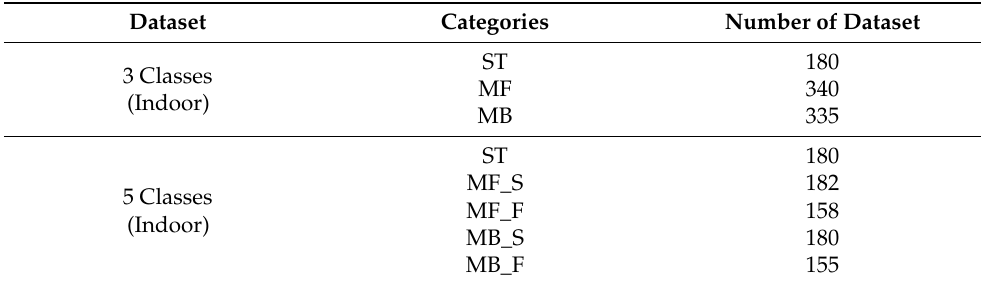
Table 2. Datasets from the Indoor Experiment.